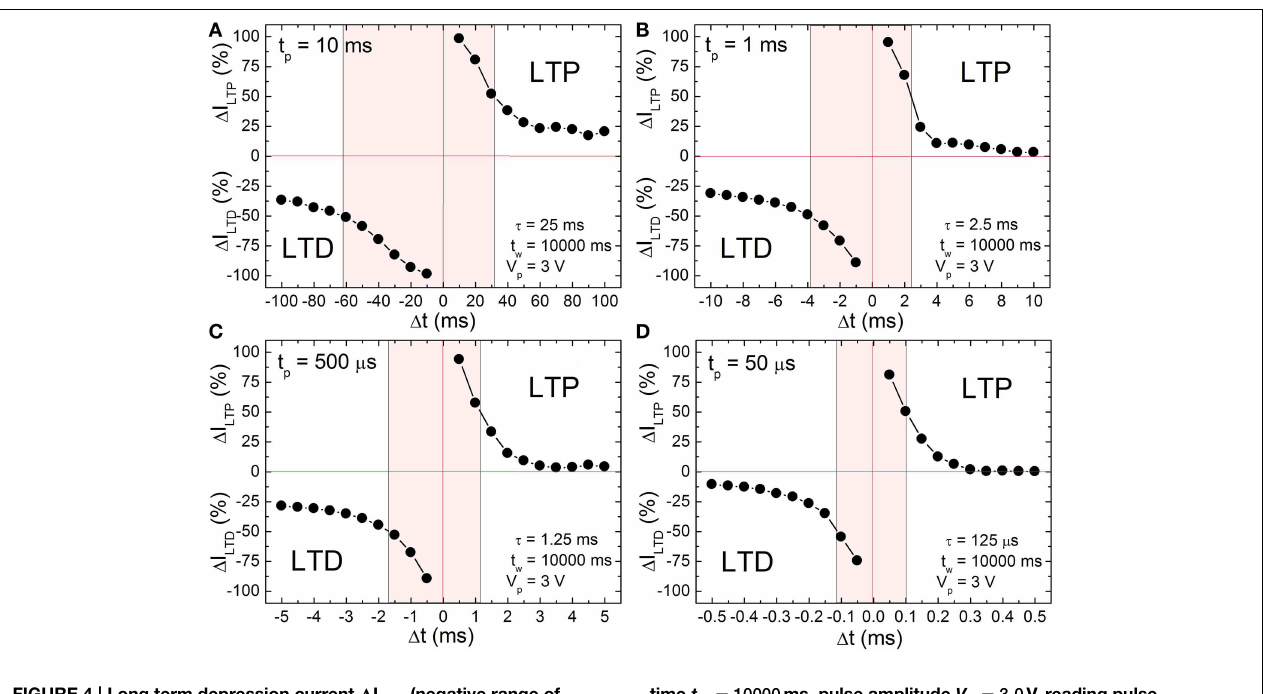
FIGURE 4 | Long term depression current 1 I LTD (negative range of y-axis) and long term potentiation current 1 I LTP (positive range of y-axis) of a ca. 600nm thick BFO memristor with a contact area of 4.5E4 µ m 2 for single pairing STDP with pulse width (A) t p = 10ms, (B) t p = 1ms, (C) t p = 500 µ s and (D) t p = 50 µ s, measurement waiting